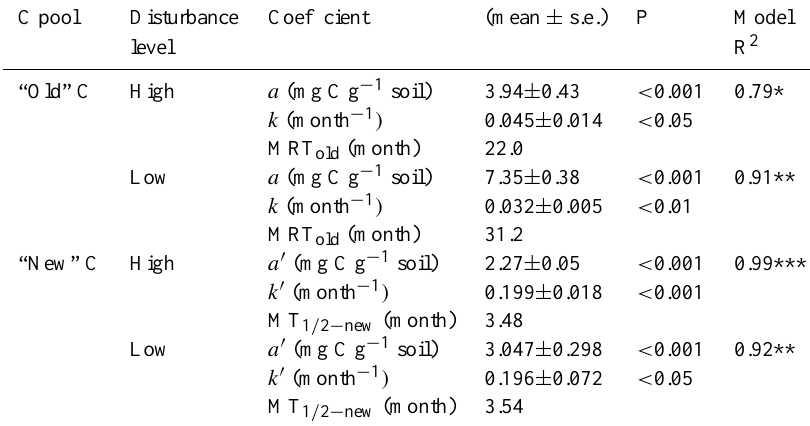
Table 1. First order exponential models of “old” C decay and “new” C accumulation in pasture monoliths adapted to low (L) and high (H) disturbance and continuously labelled with 13 C. The fate of “old” C (C old ) and the accumulation of “new” C (C new ) into SOM ( > 0.2mm) in 0–10cm soil layer were fitted to first order exponential decay and rise to maximum models, respectively: C old = a.e − k.t ; C new = a 0 .( 1 − k 0 .t ), where t is time in months; a is the initial amount of old C at t =0 (start of the labelling experiment); a 0 is the potential accumulation of “new” C (mg C g − 1 soil) in the compartment. k is the first order decay constant of “old” organic C. k 0 is the rate constant of accumulation of “new” C. Mean residence time of “old” C (MRT old , months) was calculated as: MRT old =1/ k ; the time for half-potential accumulation of “new” C (MT 1 / 2 − new ) was calculated as: MT 1 / 2 − new =ln(1/2)/ k ’. Results are means of 8 replicates per